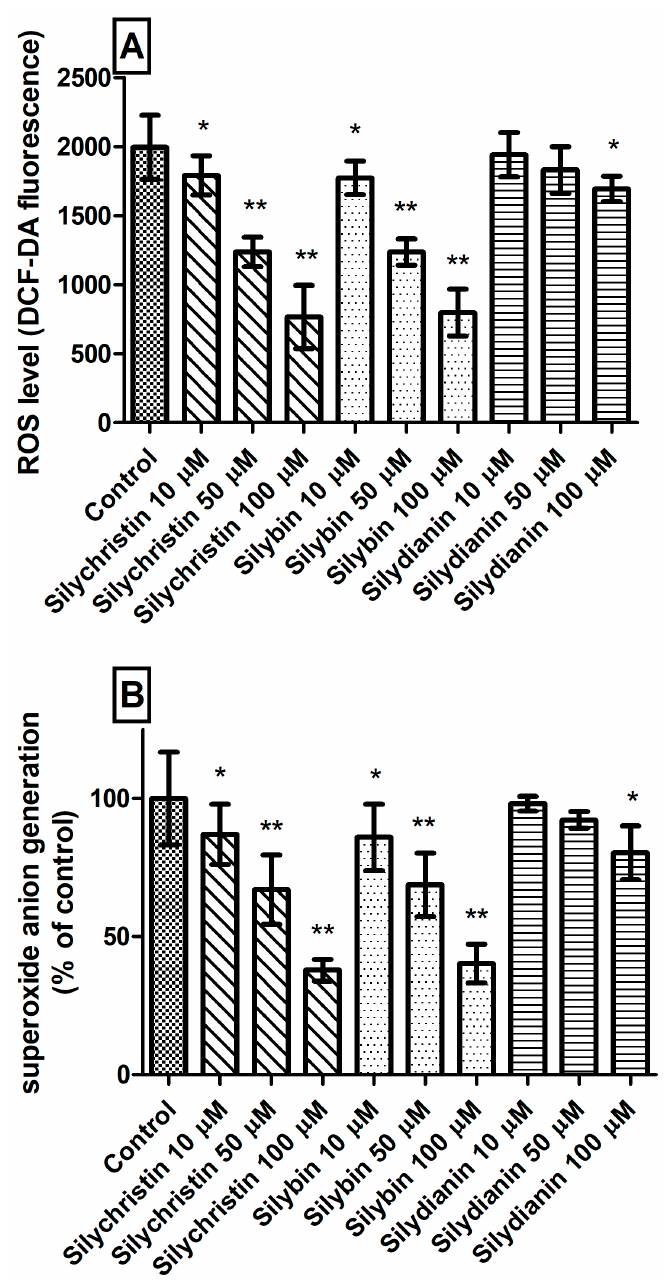
Figure 3. The effect of flavonolignans (silychristin, silybin and silydianin in concentrations of 10, 50 and 100 µ M) on generation of reactive oxygen species in blood platelets. ( A ) intracellular ROS production measured as intensity of DCF fluorescence; ( B ) superoxide anion generation measured as cytochrome C reduction and expressed as a percentage value of the control sample. The data represent means of ± SD, n = 12. Statistical analysis was performed using Tukey’s Range Test, * p < 0.05, ** p <